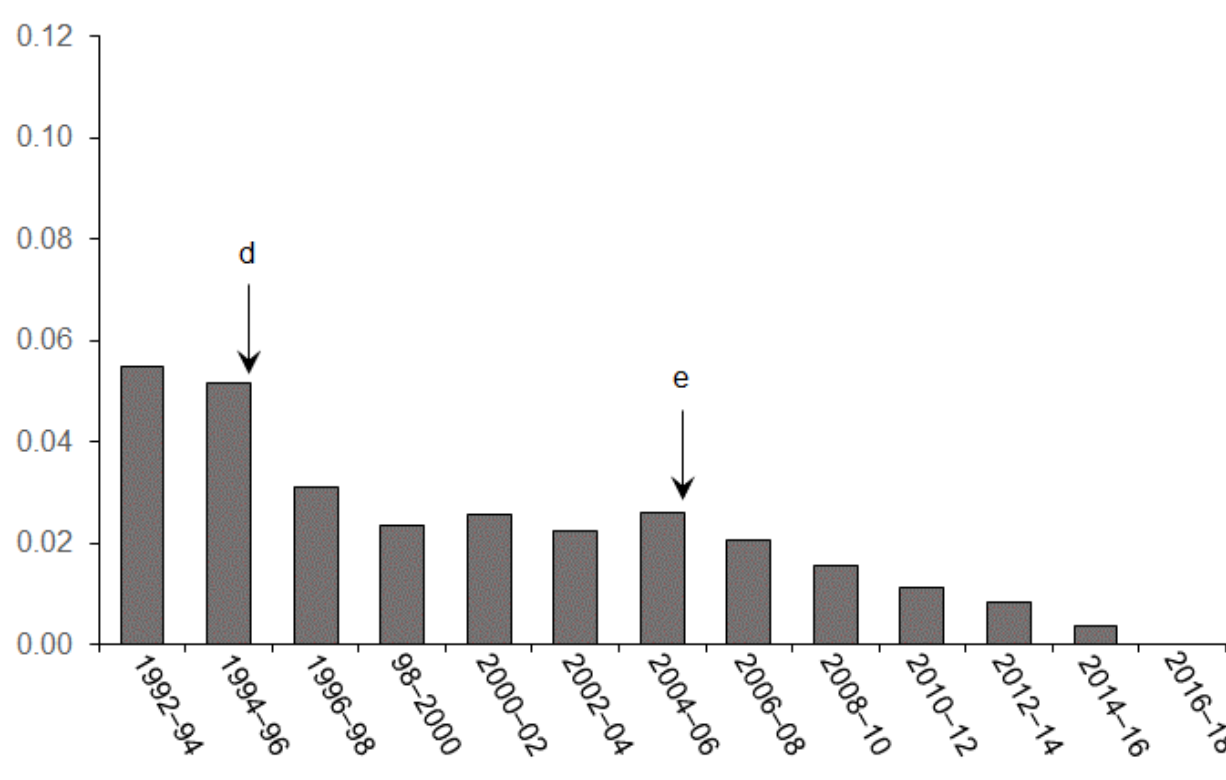
Figure 2. Effect of refinement in the surgical and microinjection procedures on septic complications. Letters indicate the chronology of various improvements introduced in the procedures. ( d ) From 1994, the inside of the cannulas was systematically sterilized. In addition, during the microinfusion procedure, the inside of the tubing, the injection needles, and the injected drugs were prepared in careful aseptic conditions. ( e ) From 2005, we implemented an asepsis chain following a “go-forward” workflow.